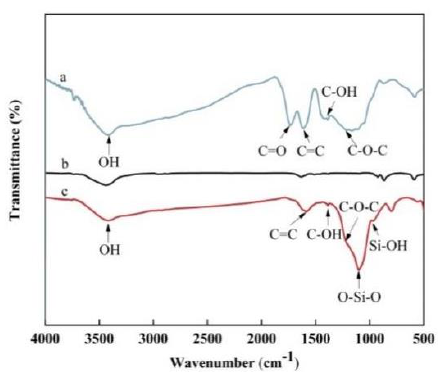
Figure 1. SEM images of graphene oxide (RGO) ( a , c ) and graphene-silica (RGO-SiO 2 ) ( b , d ) under different magnifications.